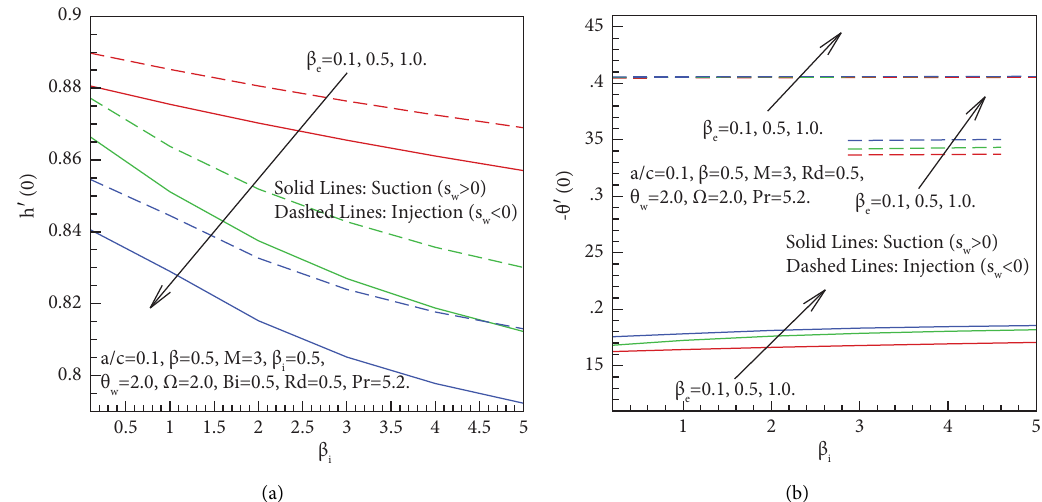
Figure 8: (a) Tangential skin friction at surface − h ′ ( 0 ) and (b) heat fux − θ ′ ( 0 ) for Hall parameter β